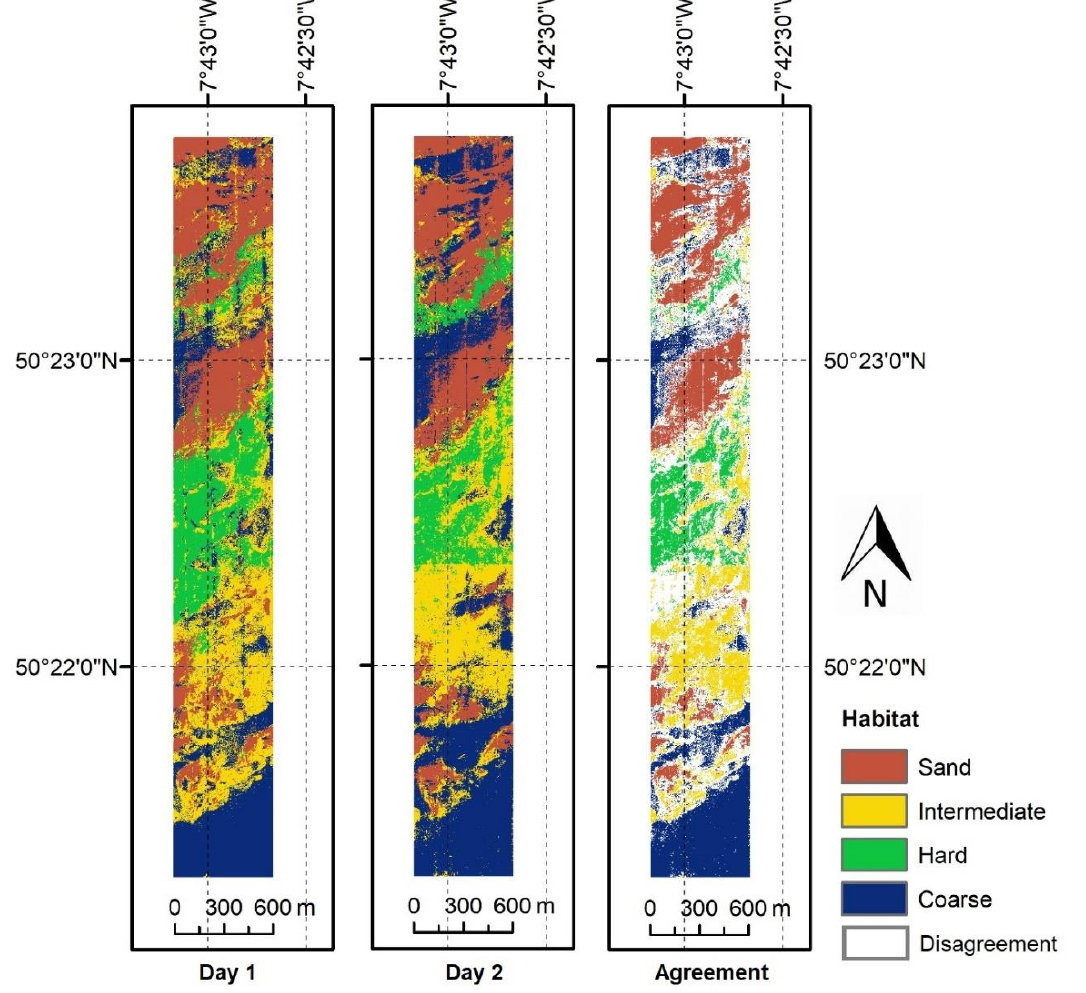
Figure 6. 2015 resulting habitat maps using Random Forest classification algorithm. Left, 2015 Day 1 map. Middle, 2015 Day 2 map. Right, agreement between maps. Mercator projection with standard parallel 50. WGS84 datum.